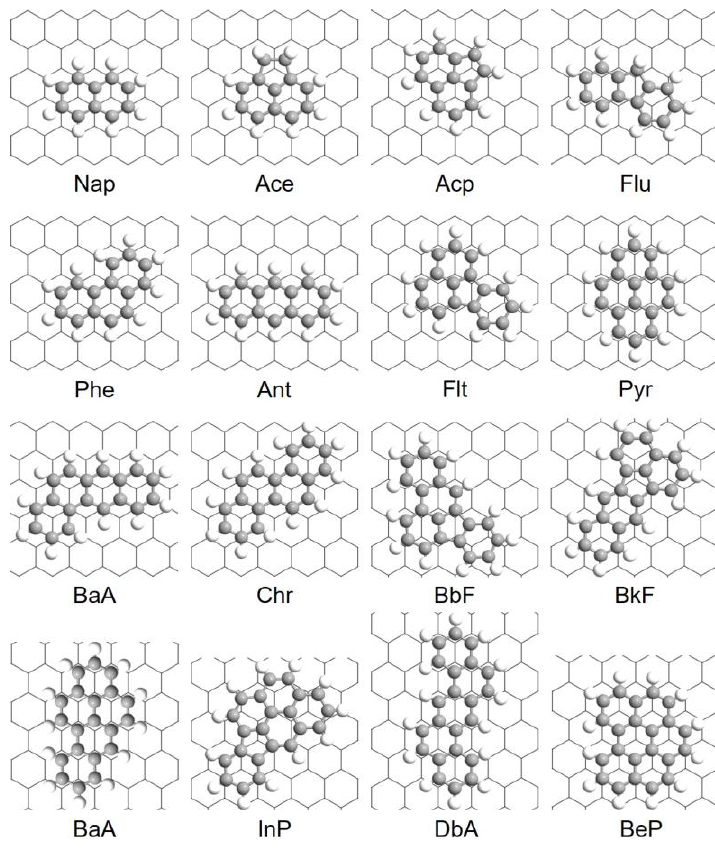
Figure 2. The most stable configurations of PAHs adsorbed onto Gr predicted by DFT calculations.